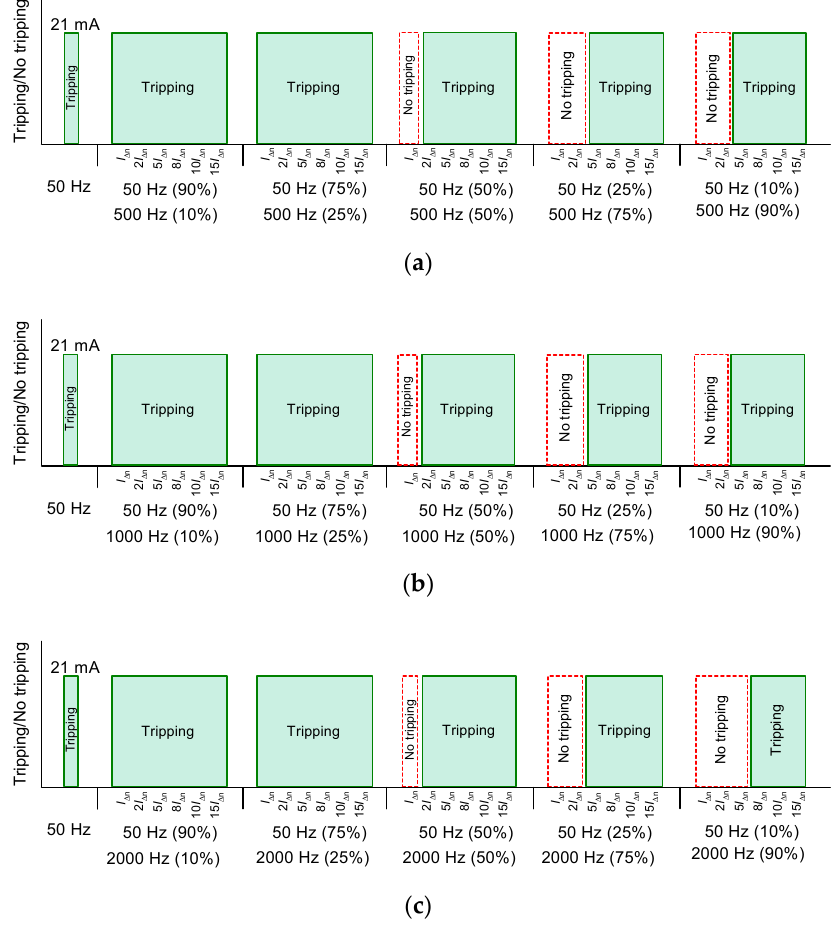
Figure 12. Tripping of the 30 mA B-type RCD (no. RCD_2B—symbol defined in Table 2) for wave- form composed of the fundamental frequency (50 Hz) and high-frequency component: ( a ) 500 Hz; ( b ) 1000 Hz; ( c ) 2000 Hz. Values in brackets indicate the content of the particular component; 21 mA— real tripping current for a pure sinusoidal signal of 50 Hz.